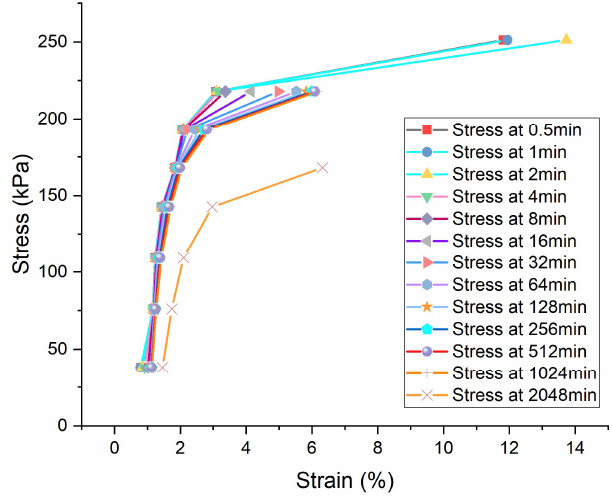
Figure 24. Isochronous (𝜎 (cid:2869) − 𝜎 (cid:2871) ) - (𝜀 (cid:2869) ) curves of Specimen No. 26, 11 FTHs.